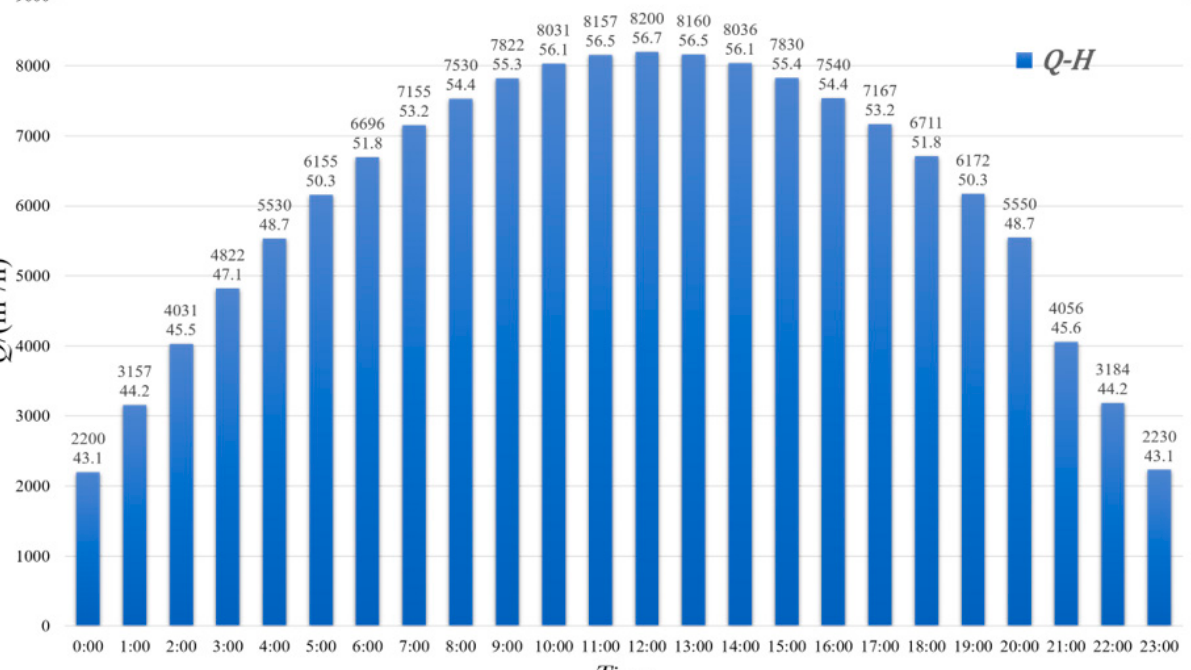
Figure 5. Water supply demands of the pumping station throughout a certain day.